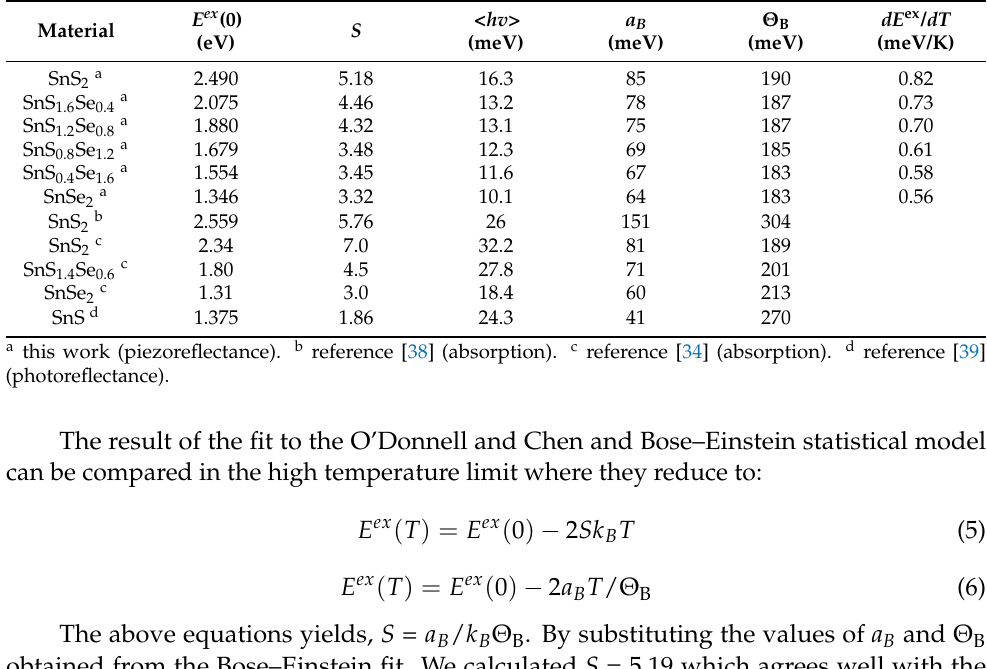
Table 2. Values of O’Donnell and Chen and Bose–Einstein type fitting parameters that describe the temperature dependence of the excitonic transition energies of SnS 2-x Se x layered